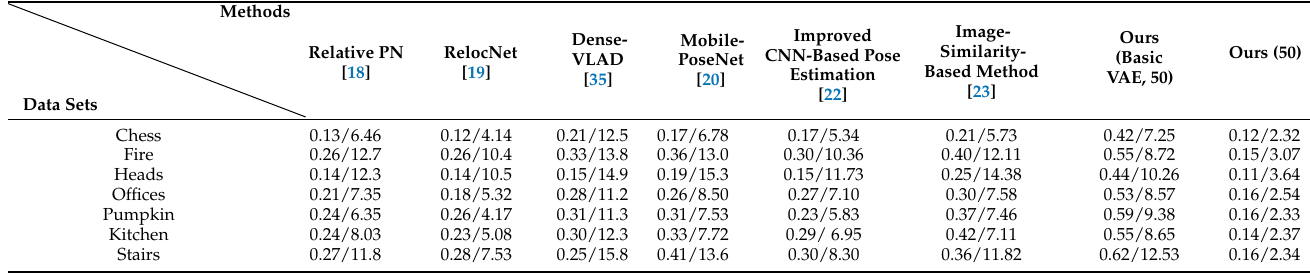
Table 2. Comparison of accuracy under the 7-Scenes data set using the mean position/orientation error (m/ ◦ ). Ours (Basic VAE, 50) means we did not use an optimized training scheme in the VAE training stage and retrieved 50 images. Ours (50) means we used the optimized training scheme and retrieved 50 images in the prior image retrieval stage.